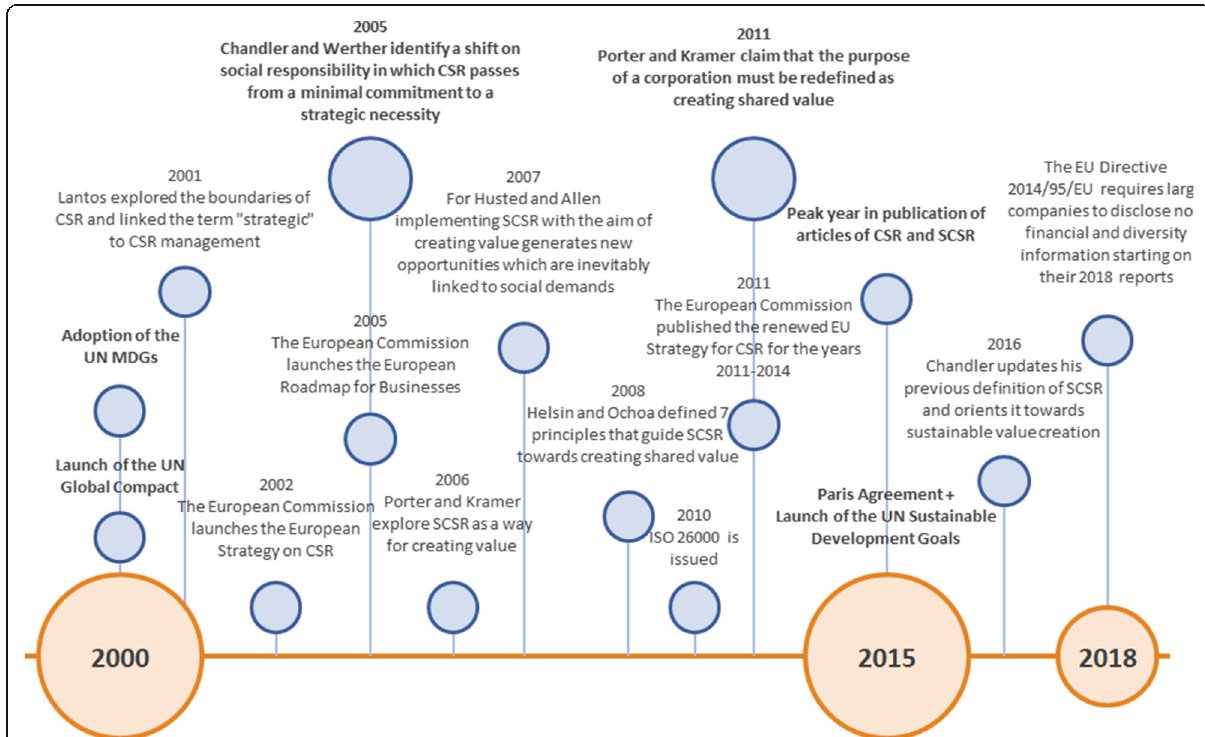
Fig. 3 Visual history of CSR (Part 2 of 2). Source: Developed by the authors based on this literature review. Note: the size of the circles is a subjective representation of the level of influence each aspect had on the evolution of CSR. Hence, a bigger circle represents a higher level of